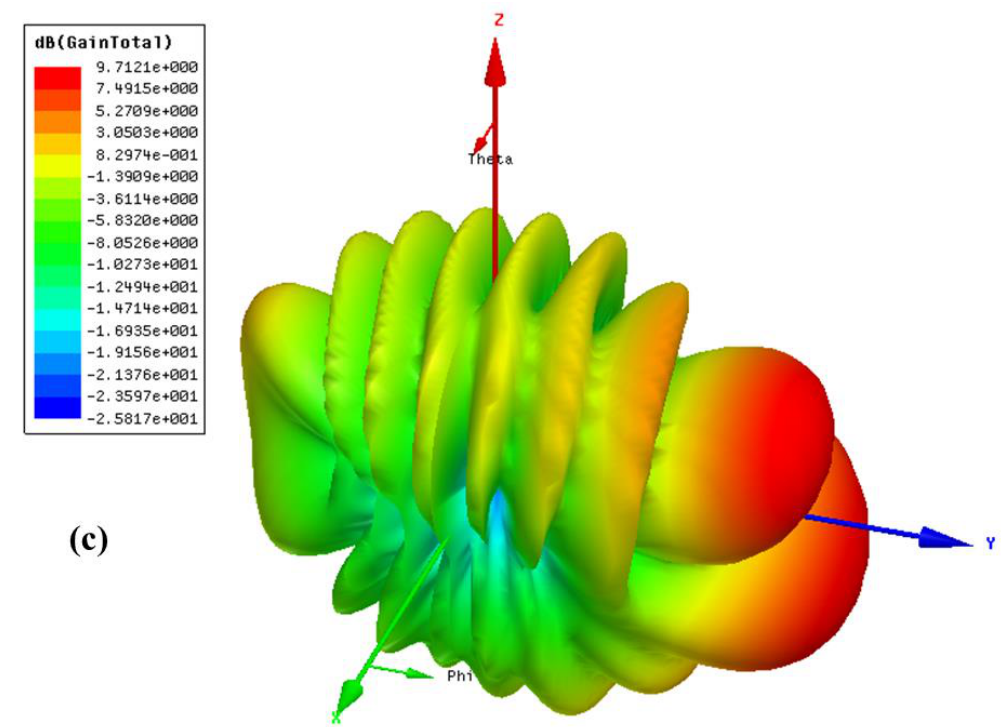
Figure 5. Microwave characterization of carbon nanotube yarns for ultra wideband( UWB) medical wireless body area networks, ( a ) a photo of the test structure with calibration structures, ( b ) SEM micrographs of carbon nanotube (CNT) yarn sample attached to golden pads (scale bar = 2 µ m), ( c ) patch antenna radiation pattern, and ( d ) measured S21 for the three 100- µ m CNT yarns on 3500- µ m substrates showing moderate absorption in transmission and resistance at dc